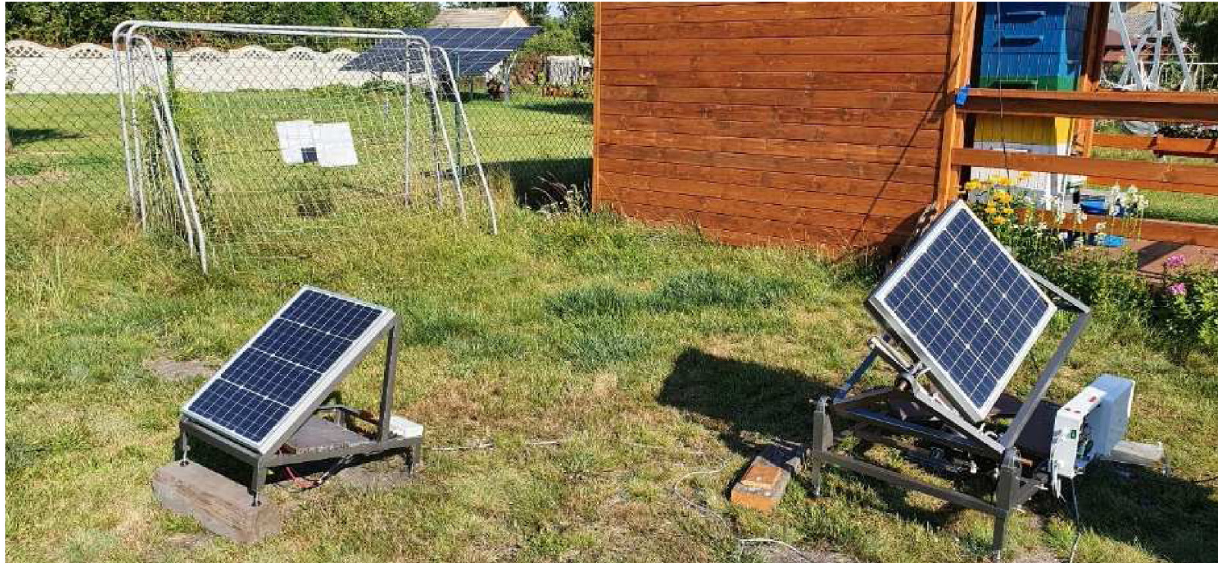
Figure 4. Completed setup placed at its final study destination. The stationary solar panel was raised to adjust its angle to around 30° which is an optimal angle for the latitude of Poland, Upper Silesia, based on the information provided by local solar panel mounting companies.